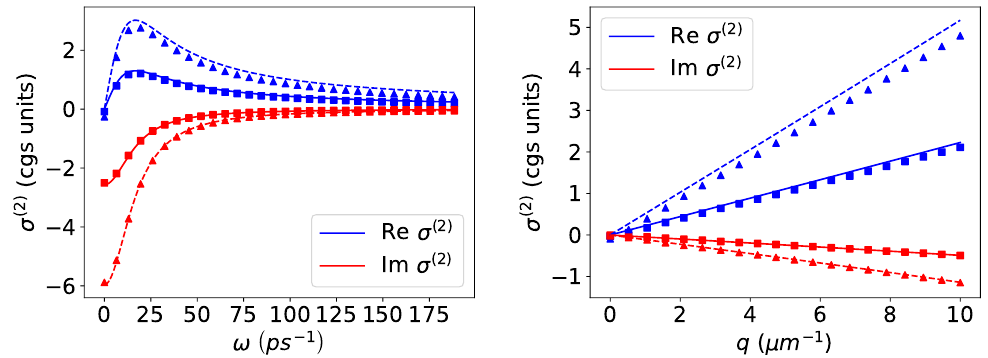
Figure 3. Real and imaginary parts of σ xxx ( ΩΩΩ , ΩΩΩ b , − ΩΩΩ a ) plotted vs ω ( left panel) and q ( right panel). The solid and dashed lines were calculated using expression (8) with Fermi levels E F = 300 and 500 meV, respectively. The triangles and squares are numerical calculations of expression (6). In the right panel, θ b was fixed at 40 ◦ , while in the left plot, ω was fixed at 94 ps − 1 . In both cases ω a = 3065 ps − 1 , γ = 10.6 meV, and θ a = 20 ◦